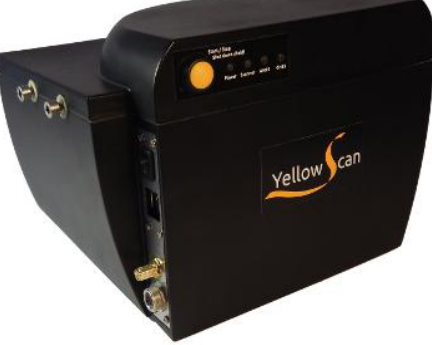
Figure 2. The YellowScan Mapper (Yellowscan.